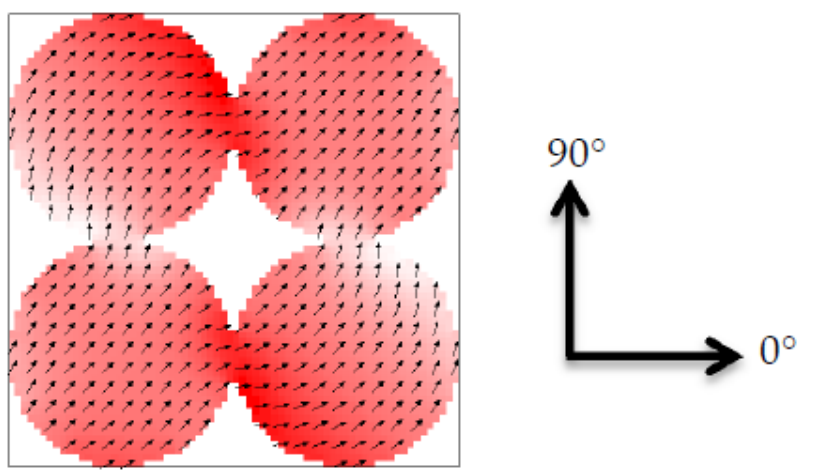
Figure 1. Sketch of the nanodot arrays under examination consisting of four touching nanodots (diameter 105 nm), surrounded by air or the other magnetic material, as well as the orientation of the external magnetic field angles. The color is defined by the magnetization pointing to the right side shown in red, magnetization to the left side depicted in blue, and magnetization pointing to the top or bottom in white.